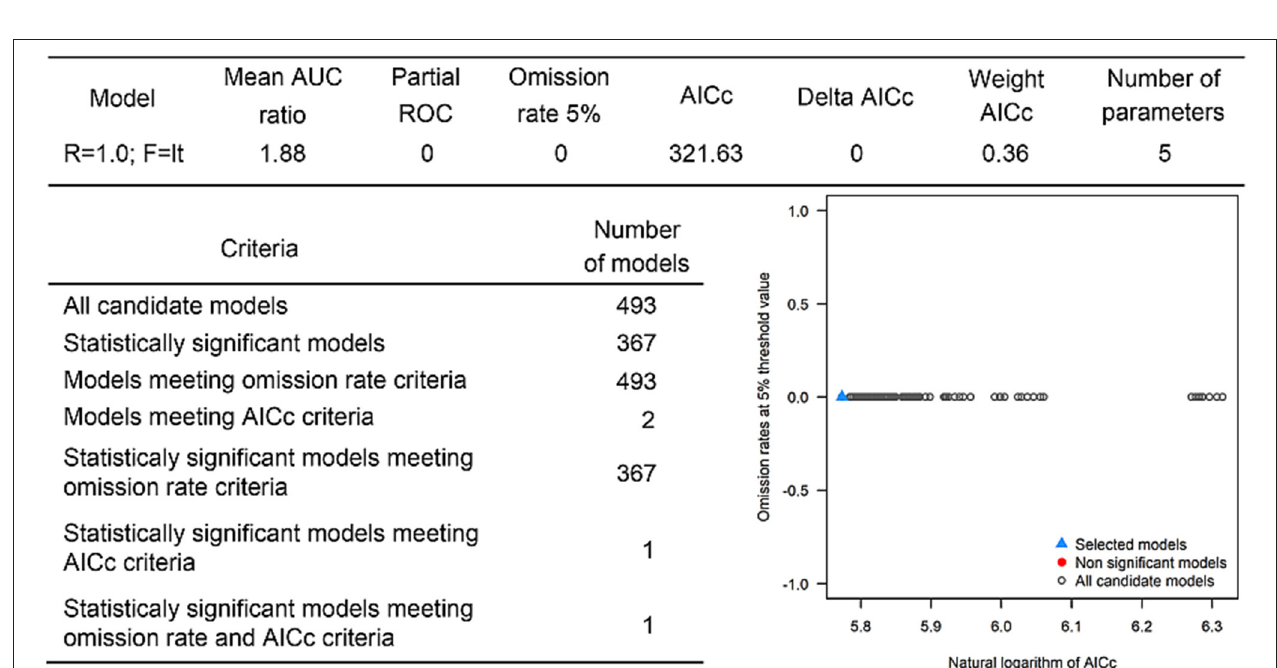
Yemen, Oman, and western China of the study area. High- risk regions were found throughout Eritrea, Ethiopia, Kenya, Uganda, Rwanda, Burundi, Tanzania, Malawi, Zimbabwe, and the southern tip of India ( Figure 7 ). The livestock density